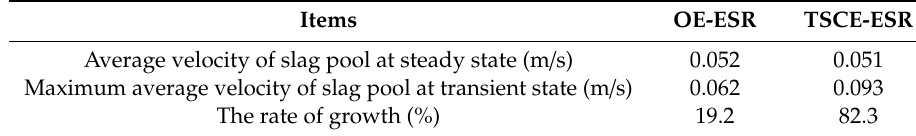
Table 4. Average velocity in steady and transient states in slag pool.